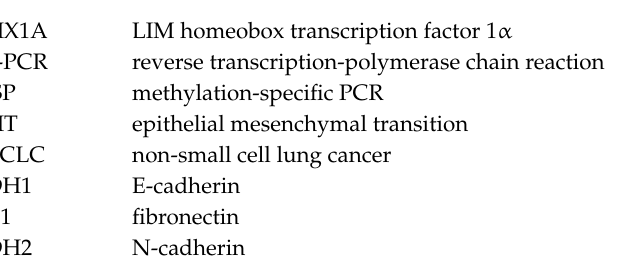
Figure S1. Bisulfite genomic sequencing analysis of the CpG sites located at the promoter region of LMX1A . Figure S2. Protein expression of LMX1A in human NSCLC cells, normal lung tissues, and NSCLC cells with expression of LMX1A-V5. Figure S3. E ff ects of LMX1A on EMT-related transcription factors in NSCLC cells. Figure S4. E ff ects of LMX1A on EMT-related genes in NSCLC cells. Figure S5. The methylation of LMX1A in NSCLC patients according to tumor stages, analyzed from The Cancer Genome Atlas (TCGA) database through the UALCAN (http: // ualcan.path.uab.edu) web portal. Figure S6. Reexpression of LMX1A after treatment of histone deacetylase (HDAC) inhibitors in H647 lung cancer cells. Figure S7. Transient overexpression of ID2 suppresses the invasion of cancer cells. Table S1. Summary of di ff erentially expressed genes that has statistical significance in LMX1A-V5 H23 cell lines by NanoString gene expression. Table S2. Primer sequences used for MSP, Q-MSP, bisulfite sequencing, and qRT-PCR. Table S3. Raw data for colony formation assay and invasion